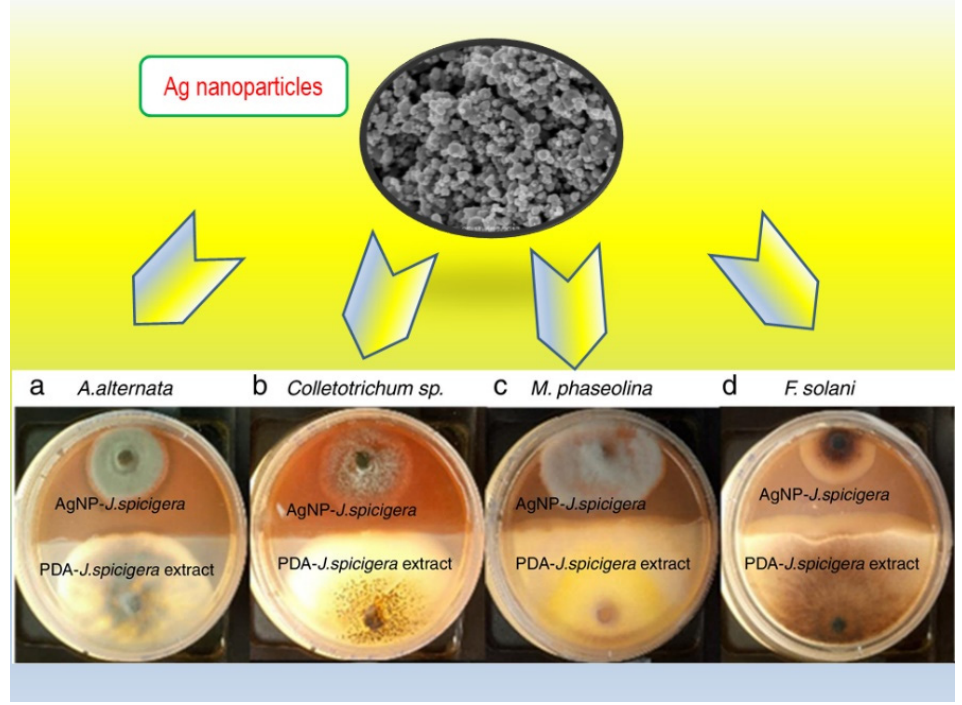
Figure 4. Ag nanoparticles based on J . spicigera aqueous extracts and their antifungal effect.